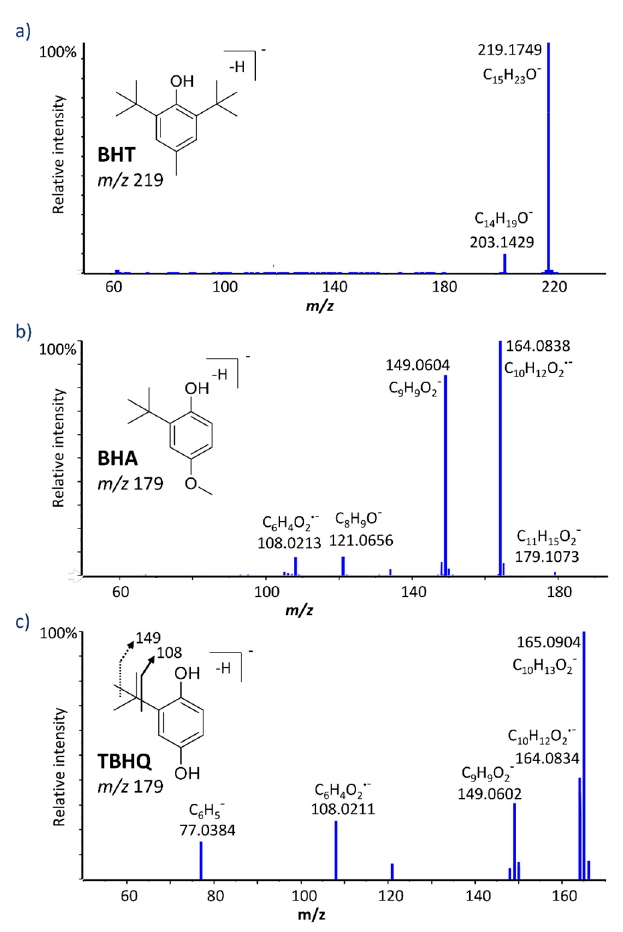
Figure 1. High resolution MS / MS spectra for deprotonated butylated hydroxytoluene (BHT) ( a ),